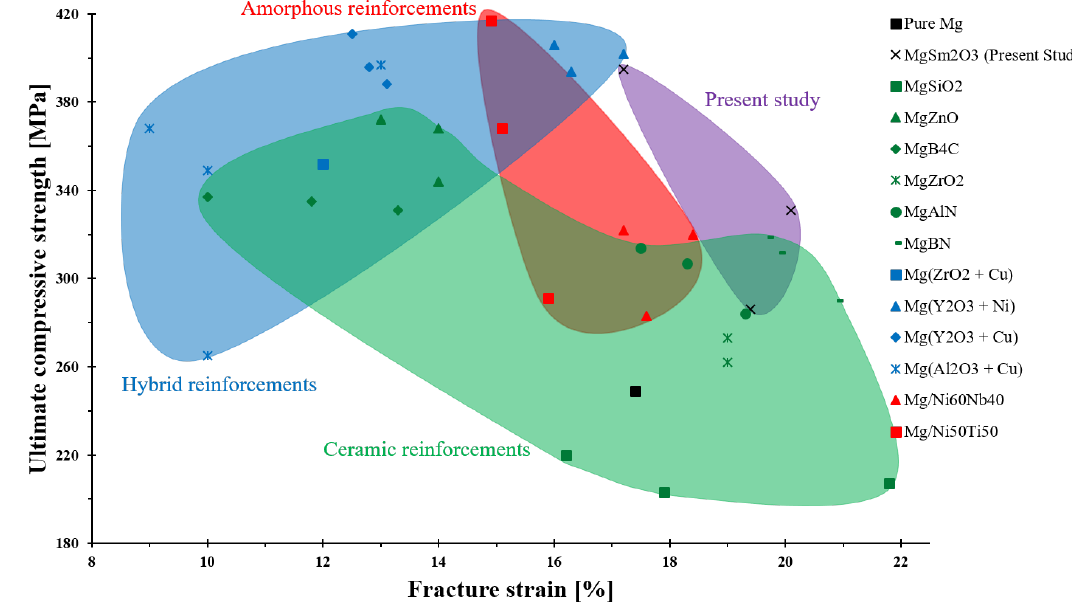
Figure 4. Bubble chart illustrating the superior compressive behaviour of Mg-Sm 2 O 3 nanocomposites compiled from references [3,10].